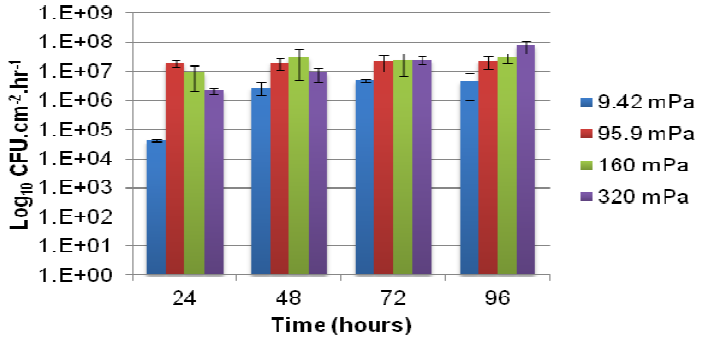
Figure 1. The viable cell numbers (colony forming units (CFU) per mL of effluent) released from biofilms, normalized with respect to the bulk-liquid flow rate (mL h − 1 ) and total substratum area (cm 2 ) available for cell attachment and biofilm development.